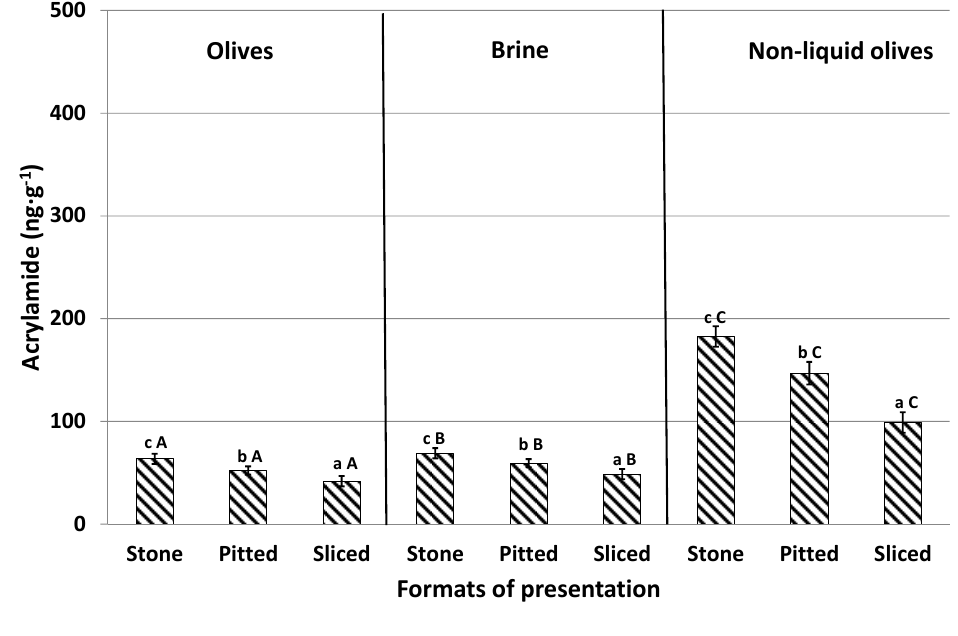
( c ) Olives of the “Cacereña” variety elaborated such as Californian-style green ripe olive with different presentation formats. Figure 3. Acrylamide content (ng g − 1 ) of olives (maturity index (MI = 0)) and brine with different presentation formats (stone, pitted, and sliced olives), canned with and without brine (non-liquid olives) after the sterilization process. Results are expressed as means ± SD of the five sample replicates. Superscript indicates significant statistical differences between presentation formats in each sample (Tukey test, p < 0.05). Different capital letters in the same columns indicate significant statistical differences between raw materials (olives, brine, and non-liquid olives) in each individual presentation format (Tukey´s test, p < 0.05).